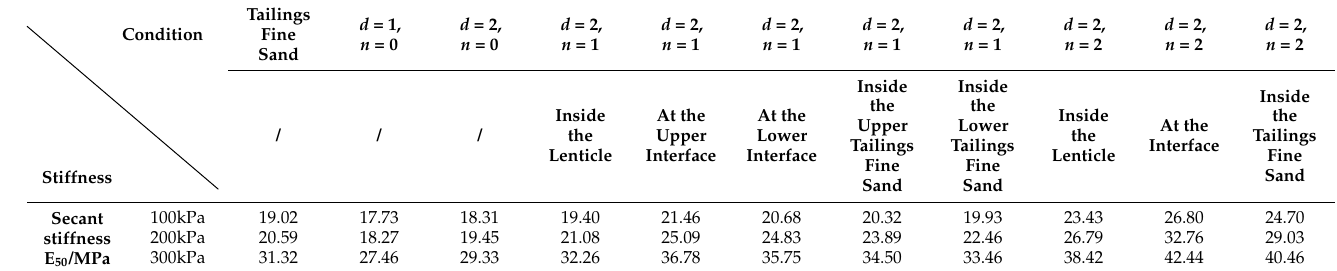
Figure 8. Secant stiffness calculation model. Table 5. The stiffness parameter of the tailings sand.